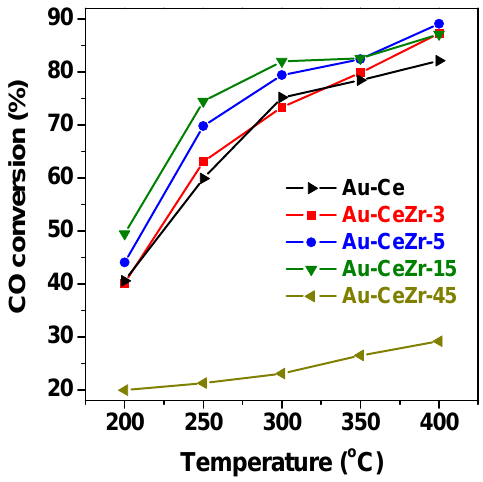
Figure 1. Catalytic activity of various Au-CeO 2 -ZrO 2 catalysts.